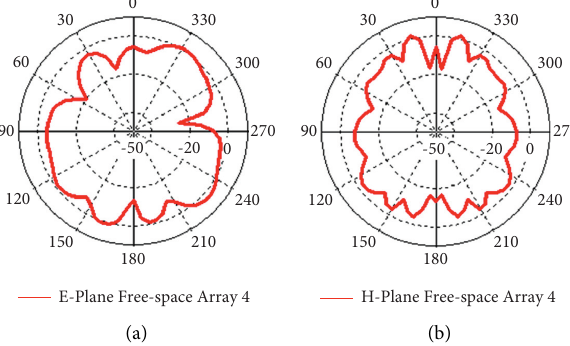
Figure 14: Radiation pattern of Array 4. (a) E-plane radiation pattern at 60GHz. (b) H-plane radiation pattern at 60GHz.